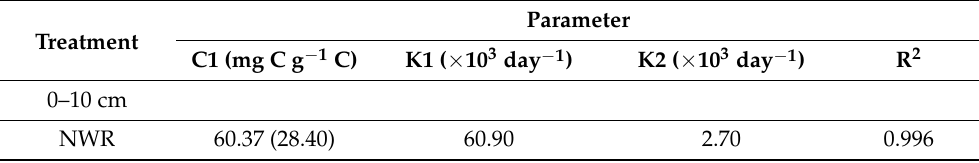
Table 7. Parameter values obtained for the carbon mineralization model (double-exponential model) fitted to cumulative carbon mineralization data for the field experiments (soil samples without straw